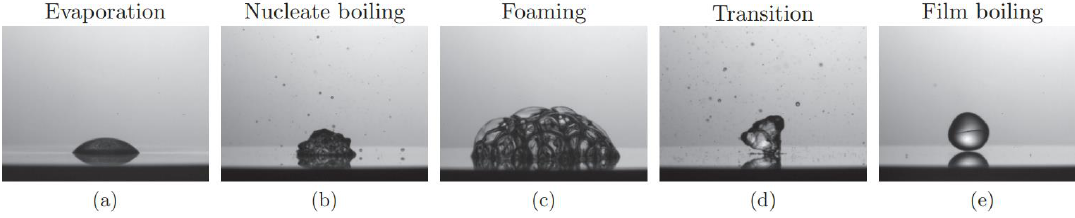
Figure 2. Outcomes of droplet collision with a hot, dry solid surface: ( a ) evaporation, nucleate ( b ) boiling, ( c ) foaming, ( d ) transition, and ( e ) film boiling (reproduced with permission from [90]).